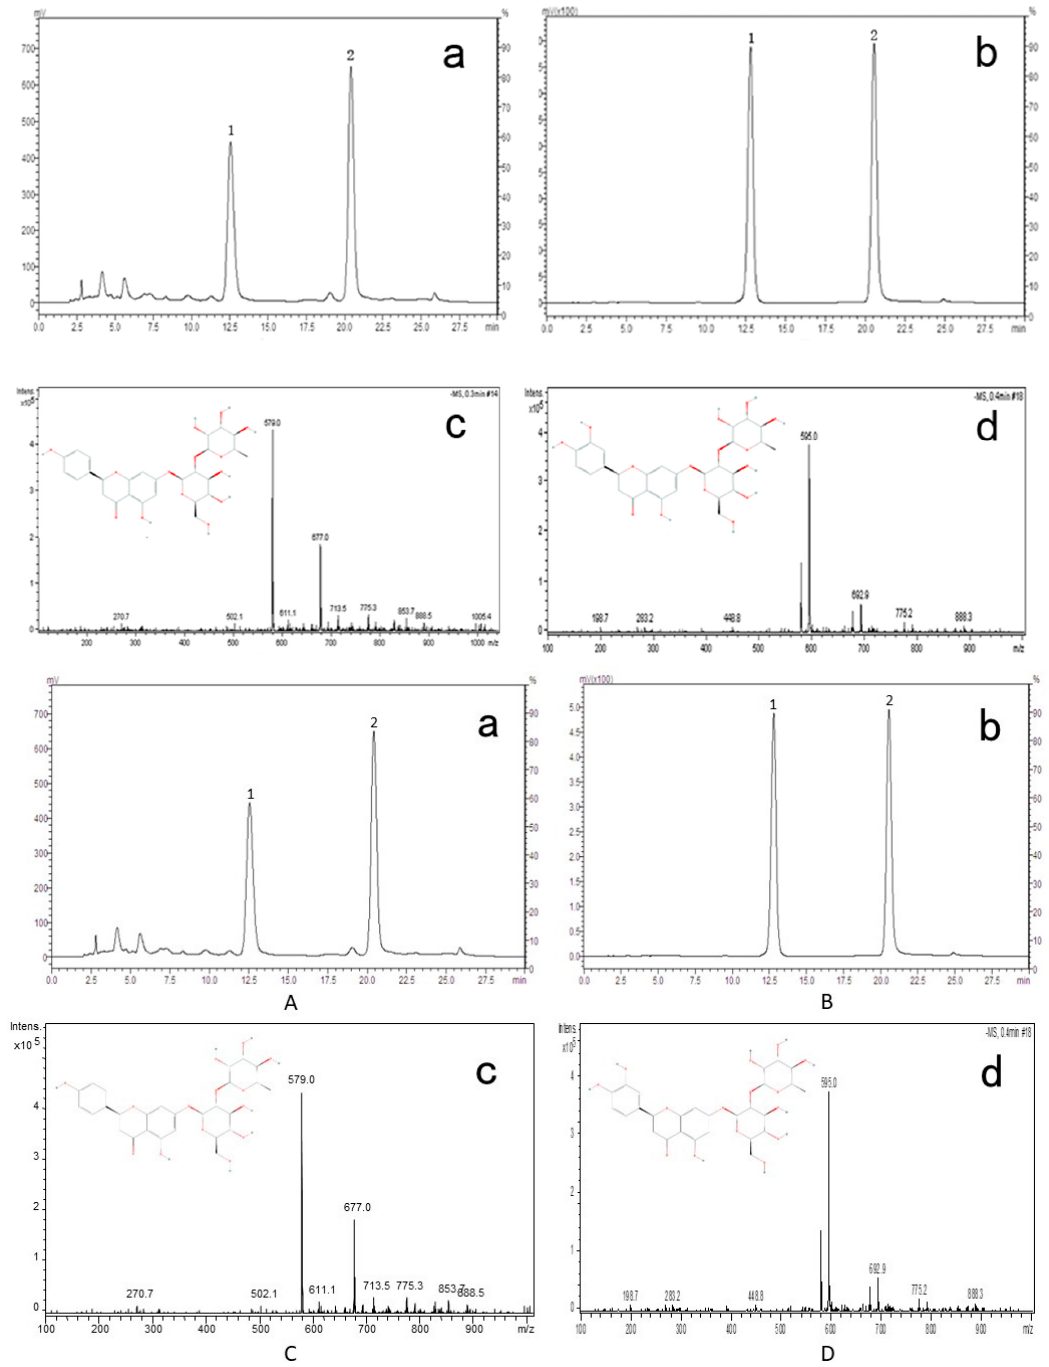
Figure 5. The HPLC chromatograms of DRTF ( a ) and standards ( b ); Peak 1 is neoeriocitrion, peak 2 is naringin. The primary mass spectrograms of naringin ( c ) and neoeriocitrion ( d ).